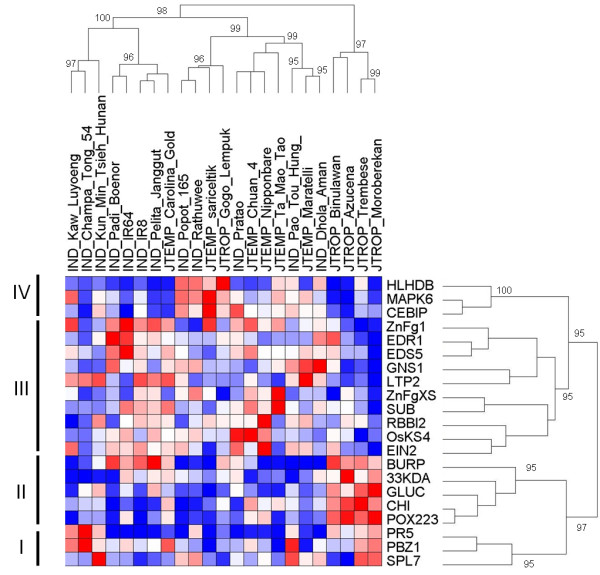
Constitutive expression of defense systems across rice diversity. The gene expression values before infection of 21 genes of 23 rice cultivars (IND = indica, JTROP = tropical japonica, JTEMP = temperate japonica) were used for hierarchical clustering using GenePattern analysis platform (http://www.broadinstitute.org/cancer/software/genepattern/index.html). Pearson correlation was used as distance and a pairwise complete-linkage as clustering method for both genes and varieties. Bootstrap values were estimated on 1000 permutations by the approximately unbiased method using R package pvclust [57]. Only boostrap values above 95 are shown. Each point represents the mean of three independent experiments. Most of the tropical japonica cultivars show a distinct expression pattern as compared to the other cultivars. The regulons are indicated by roman numbers